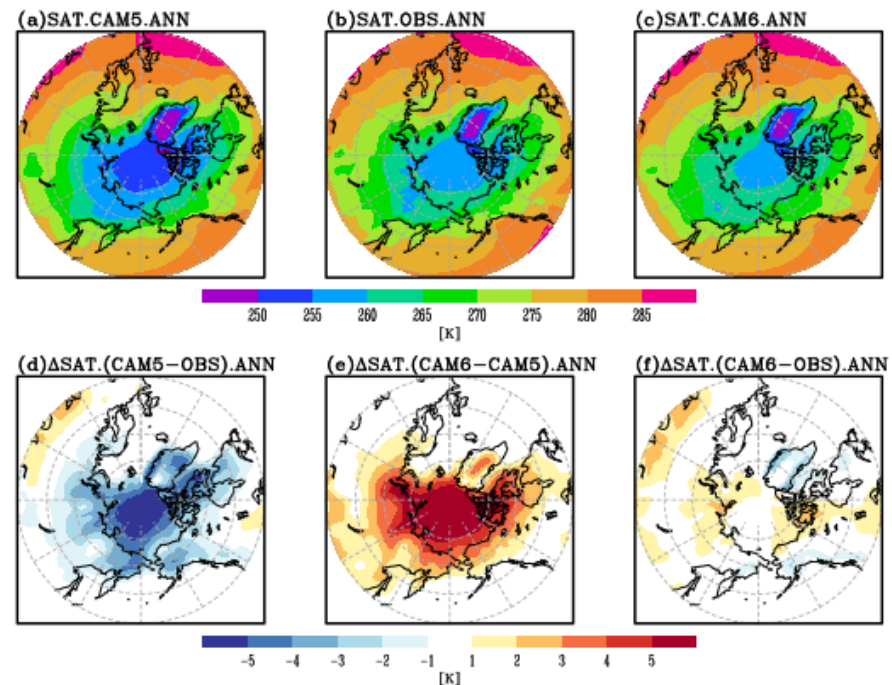
Figure 1. Annual mean surface air temperature (SAT) of ( a ) CAM5 simulation, ( b ) ERA-Interim reanalysis, and ( c ) CAM6 simulation. Biases of the SAT against the reanalysis were obtained from ( d ) CAM5 and ( f ) CAM6, and ( e ) the differences in SAT between CAM6 and CAM5.